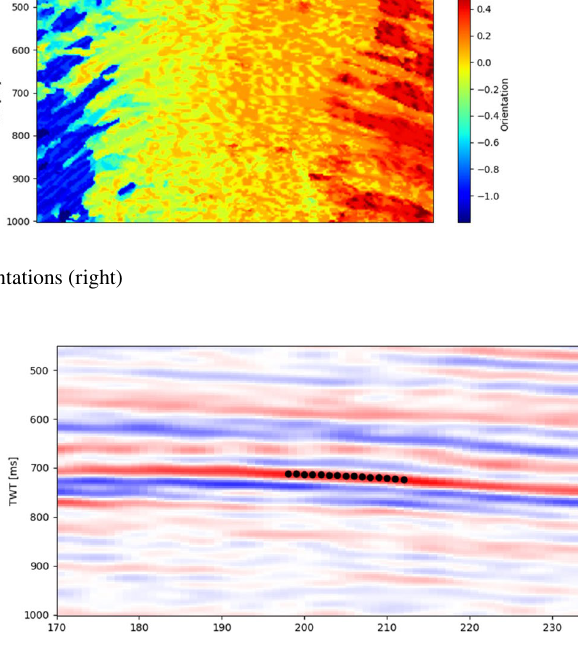
Fig. 4 Fifteen (15) points of amplitude samples are used for filter- ing. Note that the samples follow the layers’